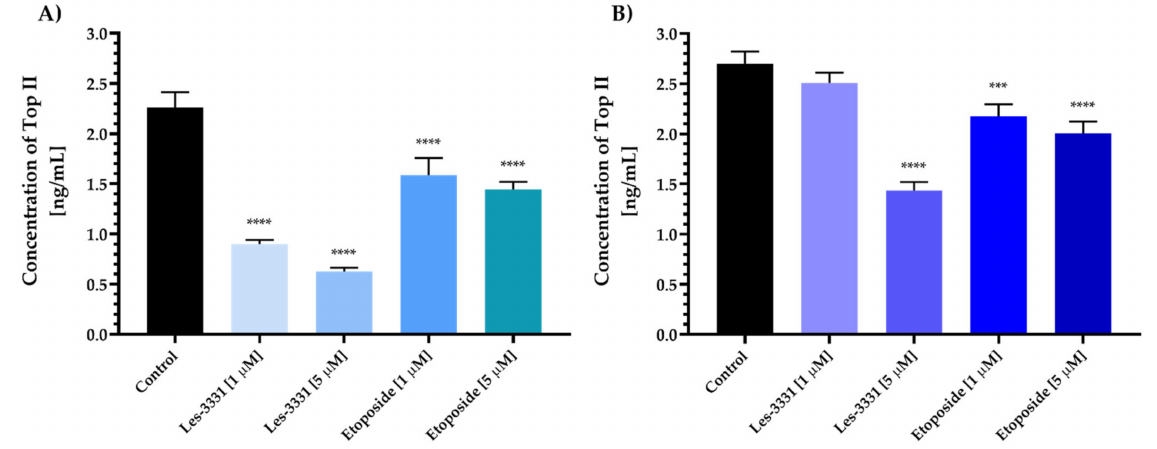
Figure 11. The concentration of topoisomerase II in MCF-7 ( A ) and MDA-MB-231 ( B ) human breast cancer cells after 24 h incubation with Les-3331 and reference drug (etoposide) at 1 µ M and 5 µ M concentration. Mean ± SD from three independent experiments performed in duplicate is presented. Statistical significance was calculated using one-way ANOVA with Bonferroni multiple comparison